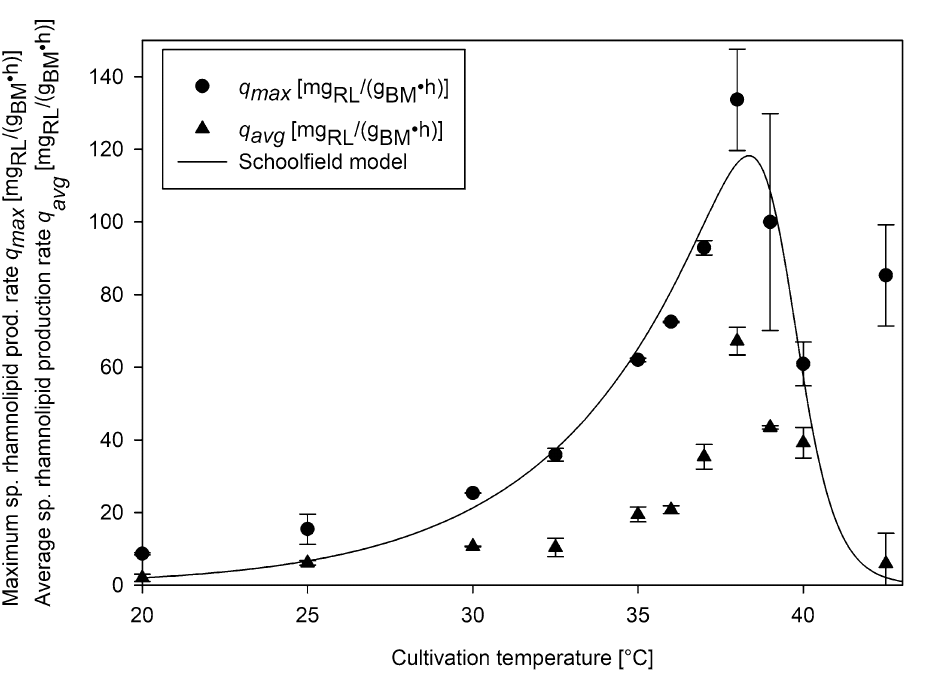
Figure 3. Experimentally determined maximum ( q max ; black circles) and mean ( q avg ; black triangles) specific rhamnolipid production rates plotted against temperatures tested for Pseudomonas putida KT2440 pSynPro8oT_4U_ rhlAB . Maximum specific rhamnolipid production rates were described as a function of temperature by fitting a temperature model (Schoolfield et al. 30 ; Eq. (1); black line) to the obtained data of q max